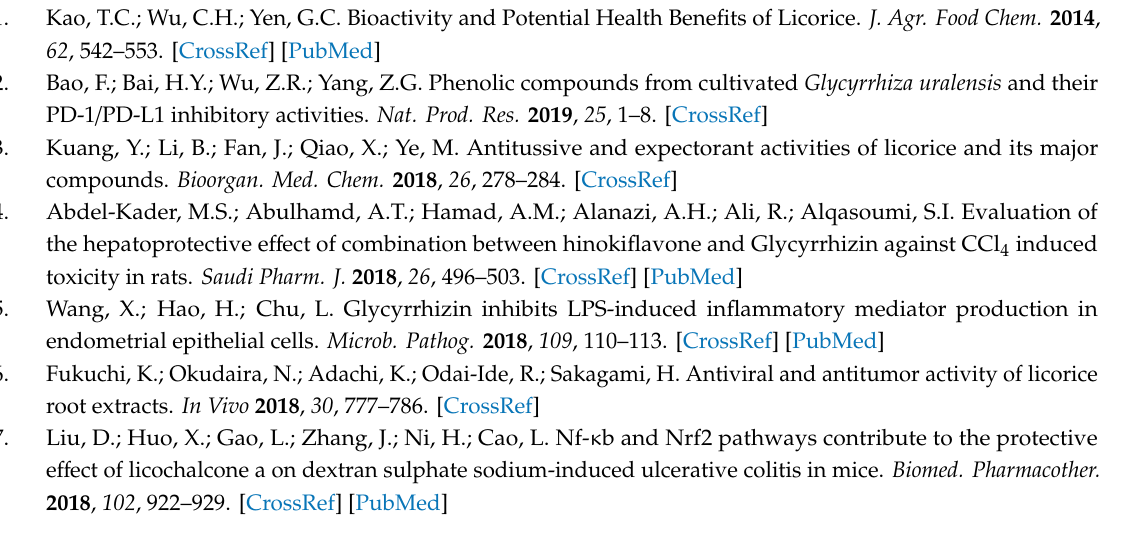
(Table S1), UV, HR-ESI-MS, 1D- and 2D-NMR spectra of compounds 1 – 9 (Figures